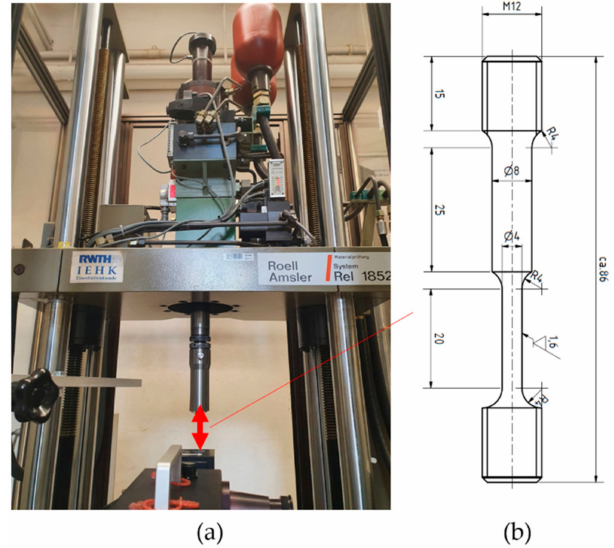
Figure 6. ( a ) Servohydraulic high-speed testing system (15 m/s) and ( b ) respective sample geometry (all dimensions in millimeters). The larger diameter is used for optoelectronic strain measurement type Zimmer 200XH.